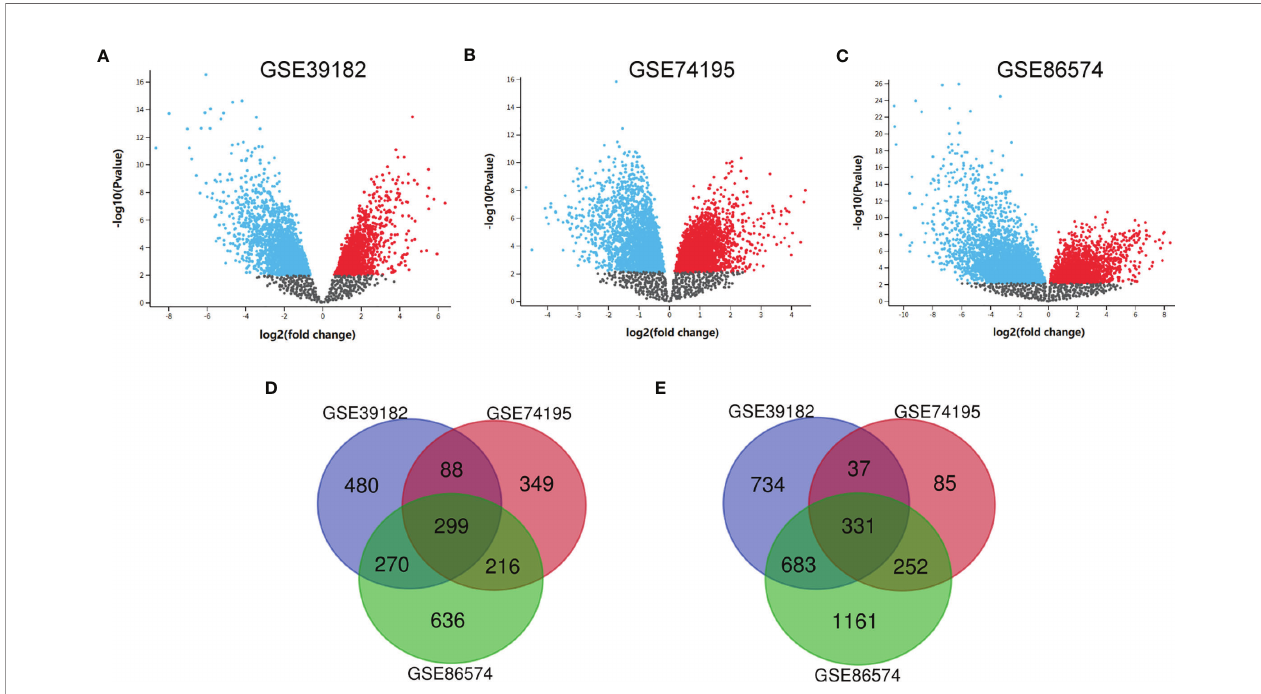
FIGURE 1 | Identi fi cation of DEGs shared between the three databases. (A) The volcano map of GSE39182, (B) The volcano map of GSE74195, (C) The volcano map of GSE86574, (D) A Venn diagram used to identify 299 upregulated target genes in MED. (E) A Venn diagram used to identify 331 downregulated target genes in